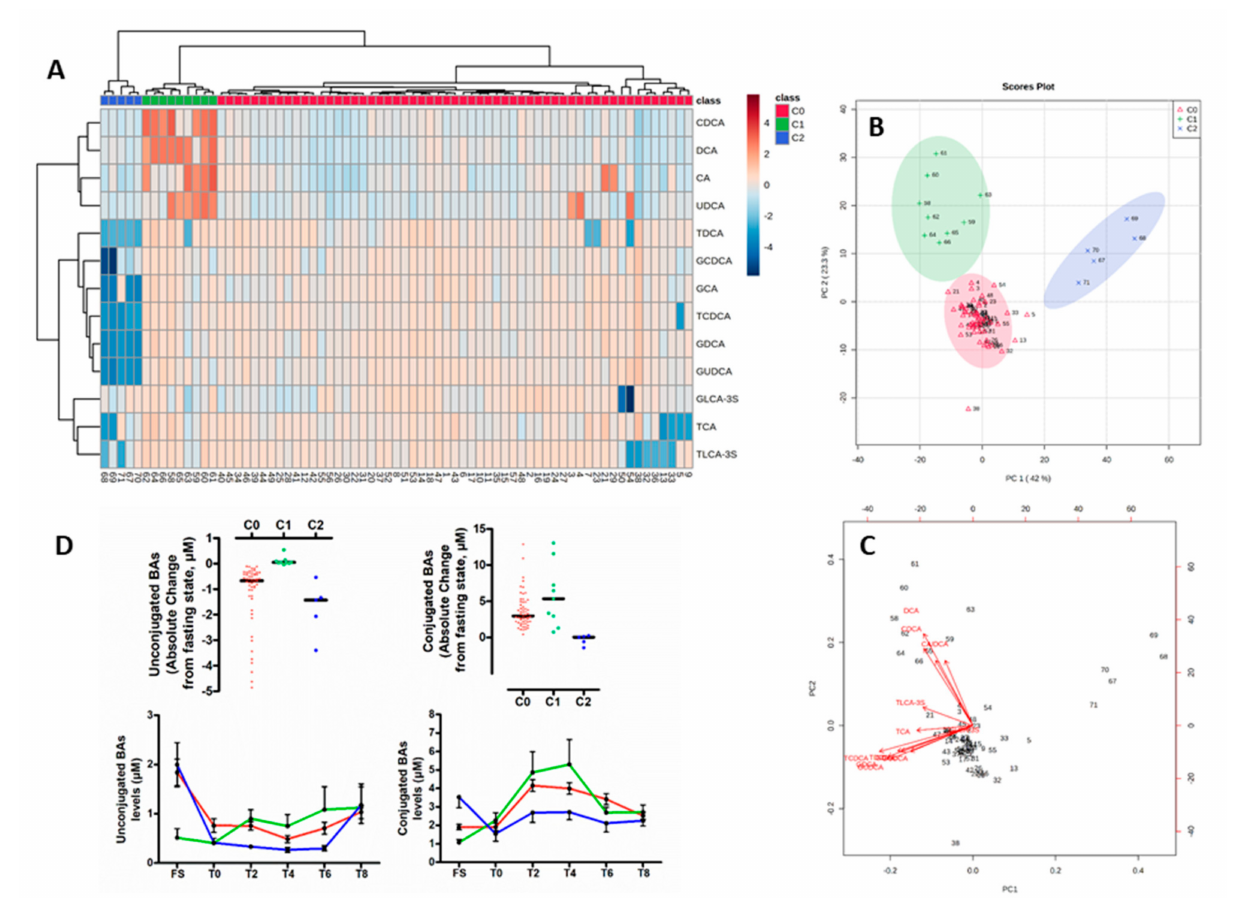
Figure 4. ( A ) Hierarchical cluster analysis of subjects based on their corresponding maximal absolute postprandial change from fasting state in circulating levels of individual BA species. Three clusters were identified and referred to C0 (n = 57, red), C1 (n = 9, green) and C2 (n = 5, blue). ( B ) PCA score. ( C ) PCA biplot. ( D ) Distribution of maximal absolute postprandial change from fasting state of unconjugated and conjugated. Black bars indicate median (upper panel) BAs according to clusters. Circulating levels of unconjugated and conjugated BAs according to postprandial time course in subjects from cluster C0, C1 and C2. Values are mean ± SEM. (bottom